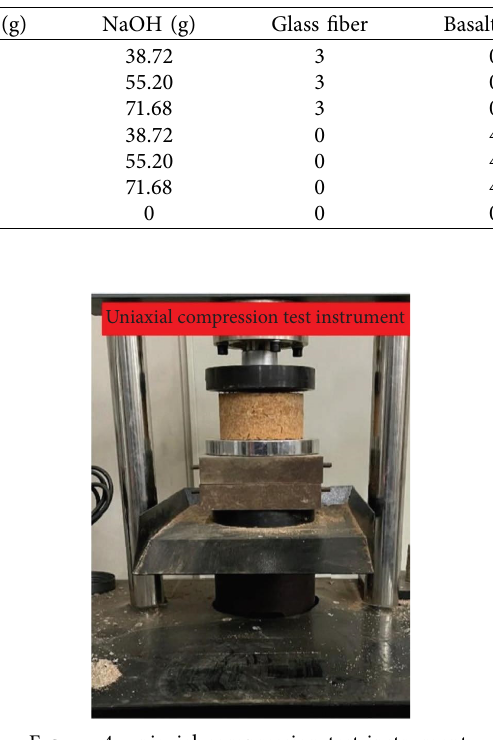
Table 4: Te drop-weight test plan.